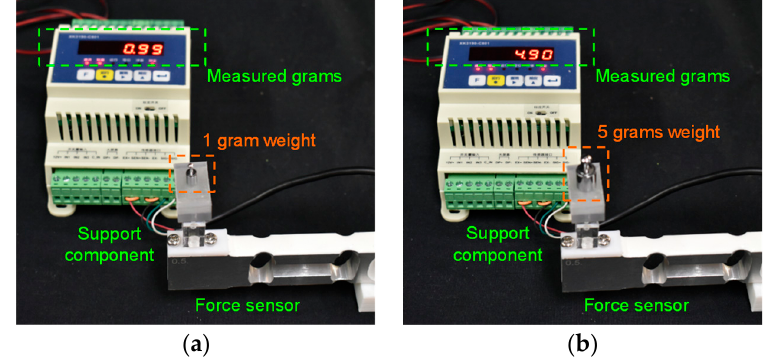
Figure 8. Measurement results for dead weights: ( a ) 1 g; ( b ) 5 g.